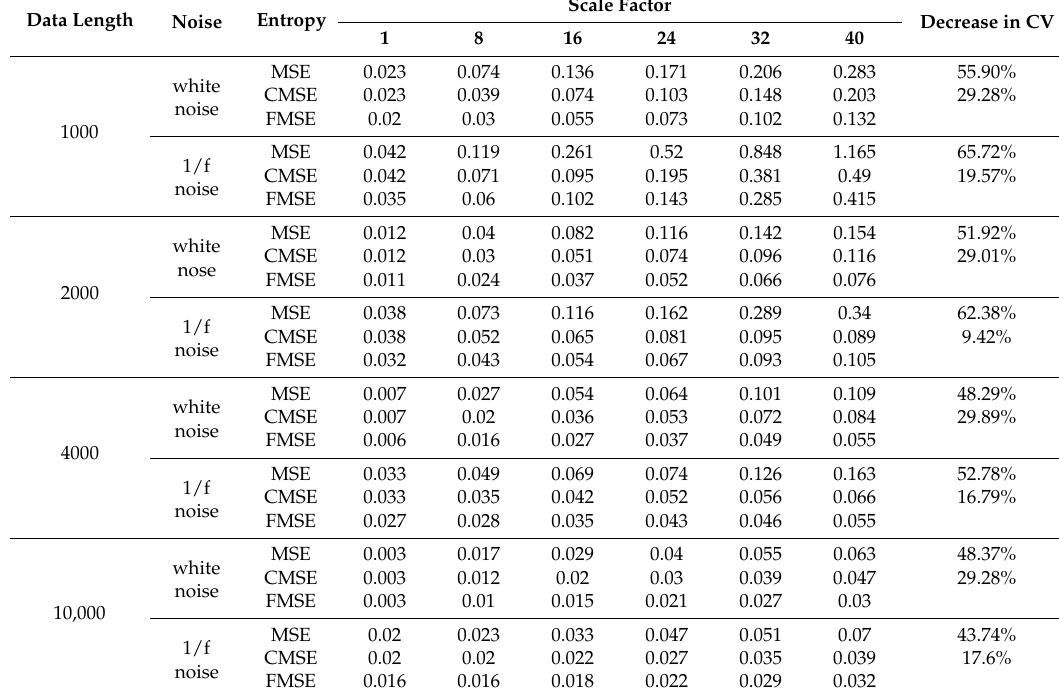
Table 1. CVs with different entropy and scale